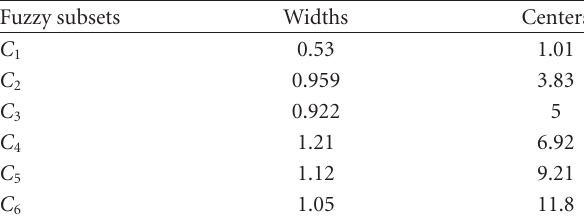
Table 3: Membership functions of N